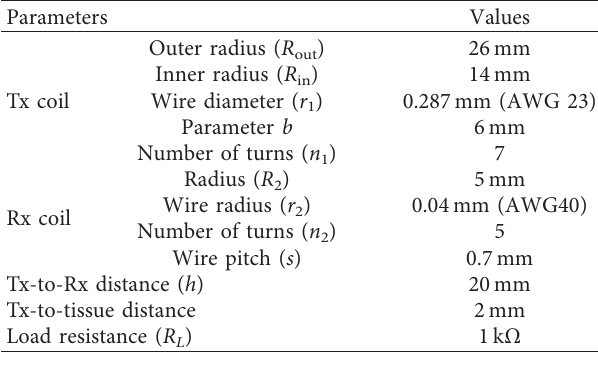
Table 2: Geometric parameters of a proposed inductive link.